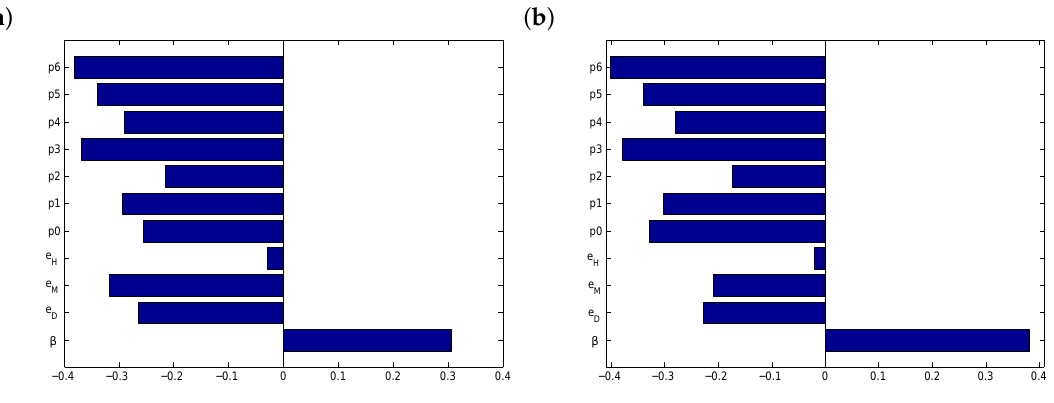
Figure 1. PRCCs before vaccine introduction for ( a ) 75–80% and ( b ) 85–90% levels of transmissibility. The outcome variable is the daily risk of infection before vaccination, r 1